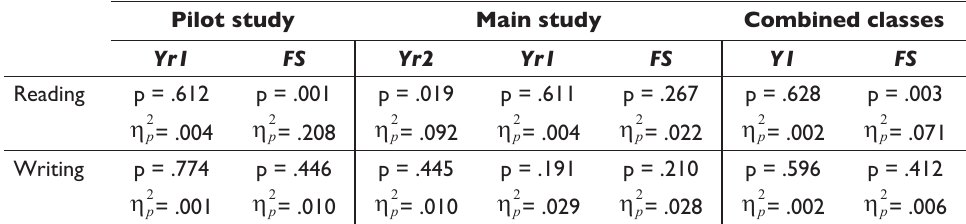
Table 4: Assessments in reading and writing in which the change in scores over time for the intervention groups was statistically significantly greater than for the controls Pilot study Main